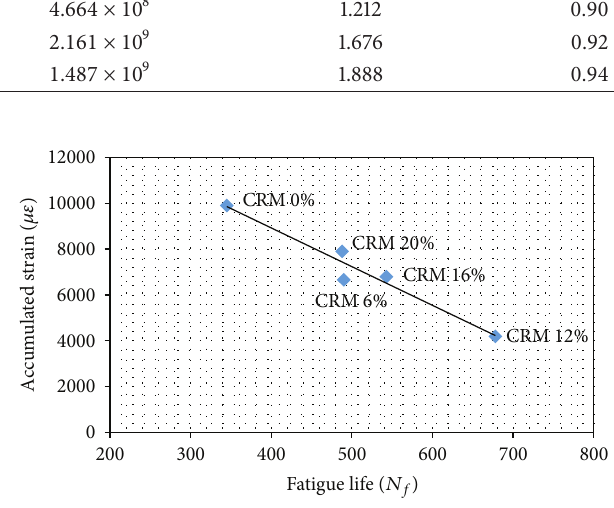
Figure 6: Fatigue life versus strain at 3000 N